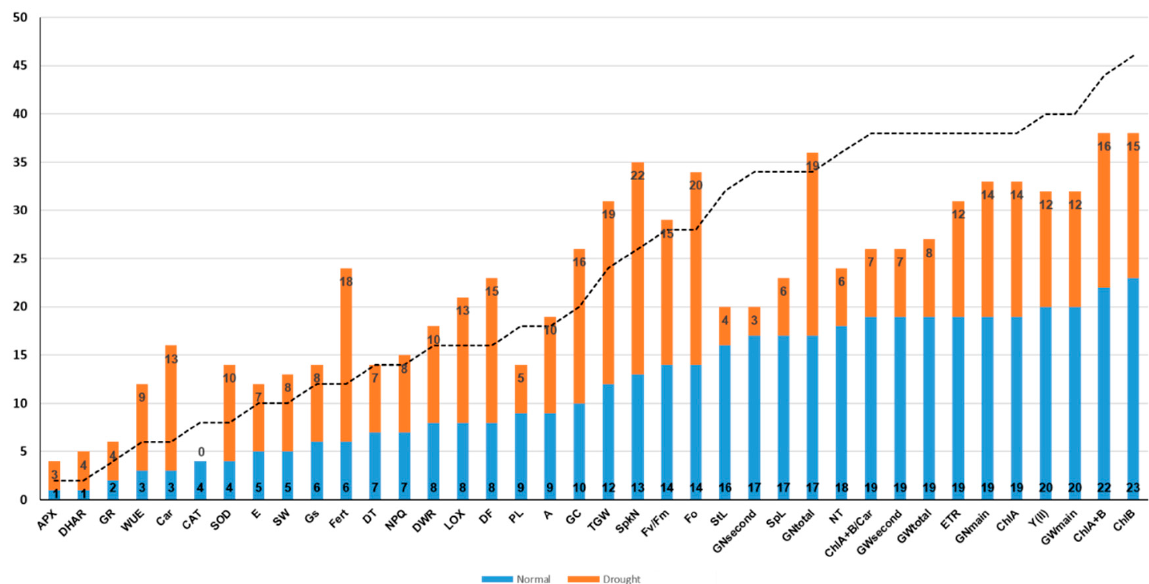
Figure 1. The number of correlations of each trait on irrigation (blue) and drought (orange). Dotted line is a formal line showing the number of correlations on drought equal to their number on irrigation. The number of correlations for the trait on drought increases if the bar is located above the dotted line. The number of correlations for the trait on drought decreases if the bar of the diagram is located below the dotted line.